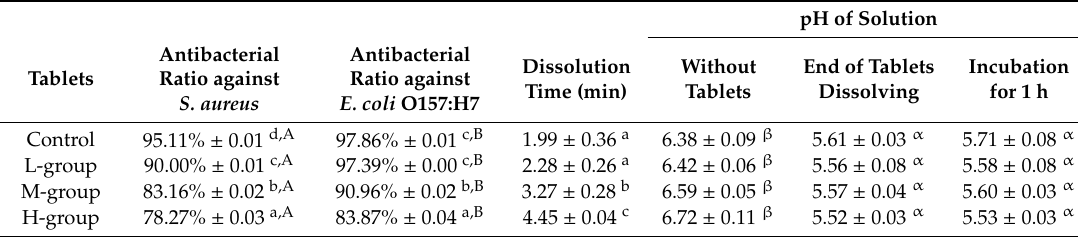
Table 6. Antibacterial activity of di ff erent kinds of lactobacilli e ff ervescent tablets against Staphylococcus aureus and Escherichia coli O157:H7 for one-hour incubation.